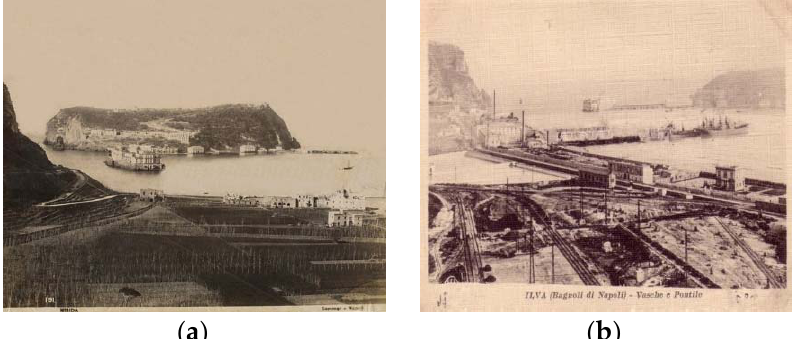
Figure 3. ( a ) Nisida and lazzaretto—Bagnoli (G. Sommers) “Isle of Nisida”(Catalogue #: 1191) [11]; ( b ) Ilva 1905: Tanks and pier [14].